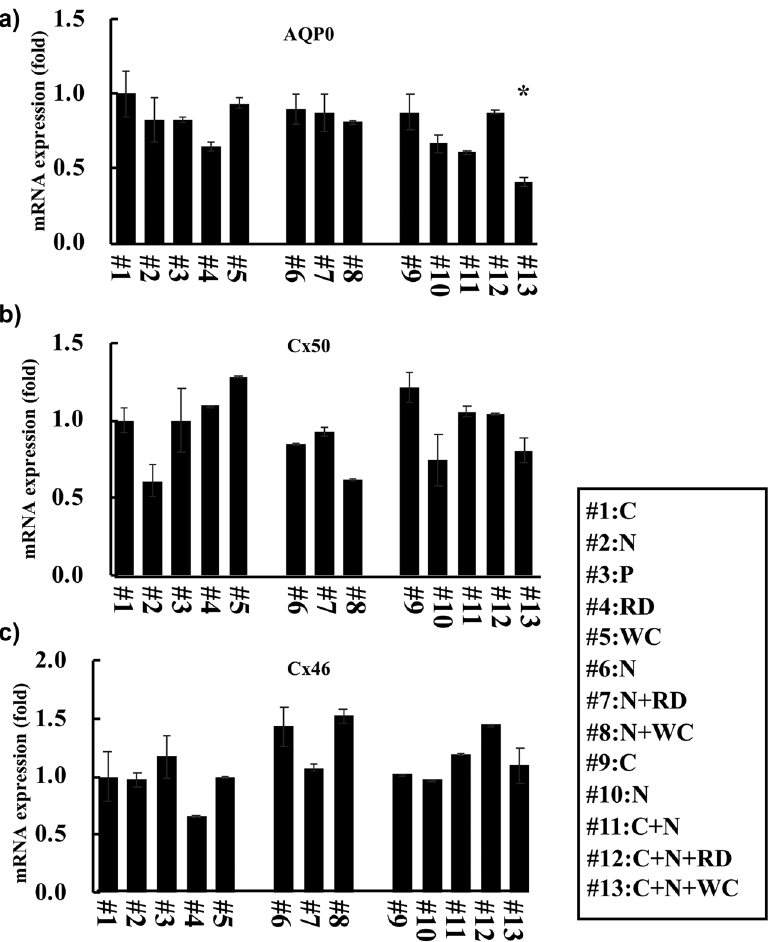
Figure 2: mRNA expression in several types of cataract patients. ( a ) AQP0 mRNA expression, ( b ) Cx50 mRNA expression, and ( c ) Cx46 mRNA expression in several types of cataract lens was measured by real - time PCR. C: COR patient, N: NUC patient, P: PSC patient, RD: retrodots cataract patient, WC: watercleft cataract patient, N + RD: NUC with RDs, N + WC: NUC with WC, C + N: COR with NUC, C + N + RD: COR with nuclear and RDs cataracts, and C + N + WC: COR with nuclear and watercleft cataracts. Beta - actin was used as an internal control.